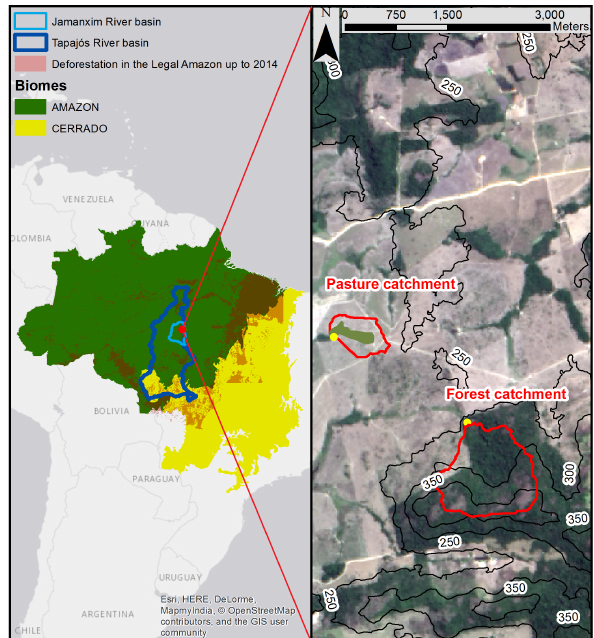
Figure 1. Area of